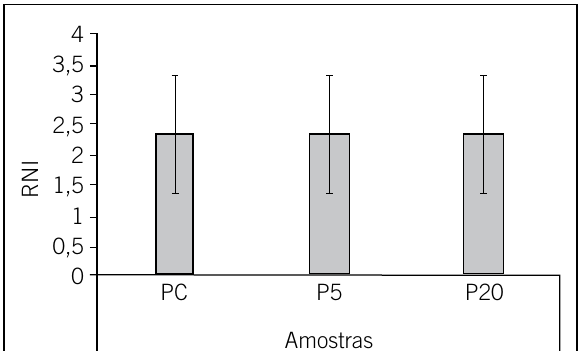
Figura 2 – RNI: relação normatizada internacional; PC: plasma comercial.